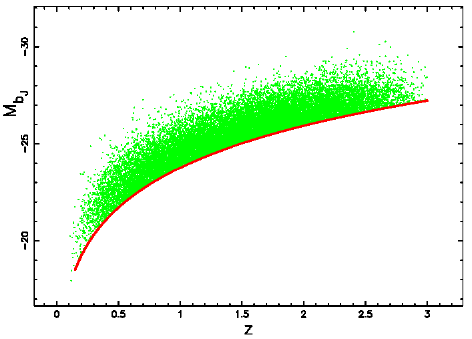
Figure 1. The absolute magnitude M B computed with the nonlinear Equation (36) for 22,413 bj QSOs versus the redshift (green points). The lower theoretical curve (upper absolute magnitude) as represented by the nonlinear Equation (37) is the red thick line. The redshifts cover the range [ 0,3 ]